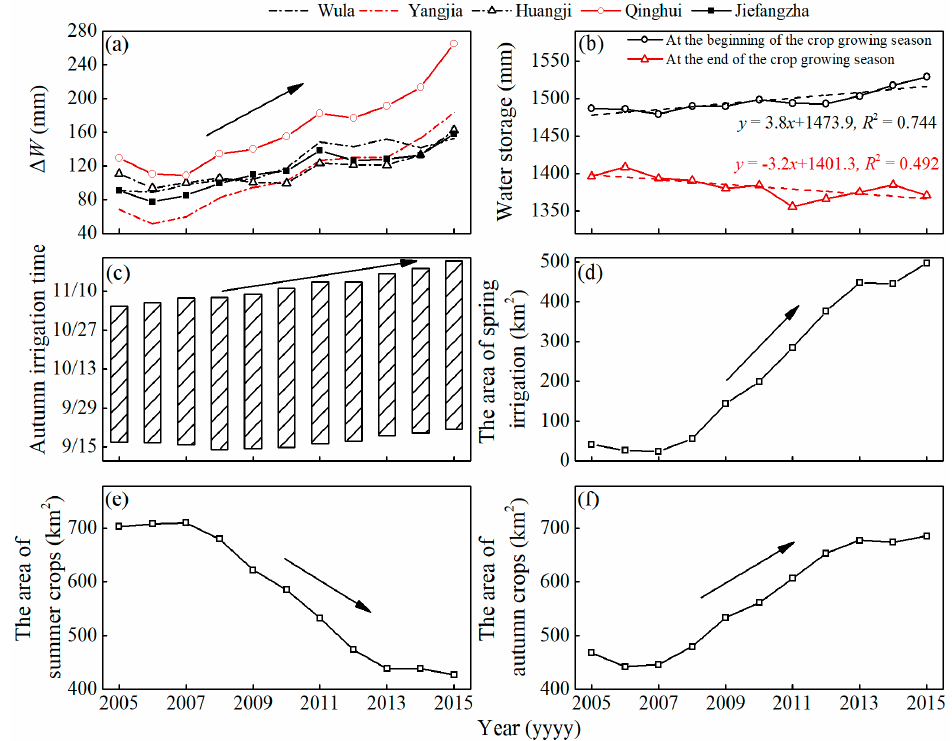
Figure 5. The moving average results of ( a ) the soil ‐ ground water utilization ( Δ W ) in Jiefangzha and its four subareas, ( b ) the water storages at the beginning and end of the crop growing season in Jiefangzha, ( c ) the autumn irrigation time in Jiefangzha, ( d ) the area of spring irrigation in Jiefangzha, ( e ) the area of summer crops in Jiefangzha, and ( f ) the area of autumn crops in Jiefangzha.